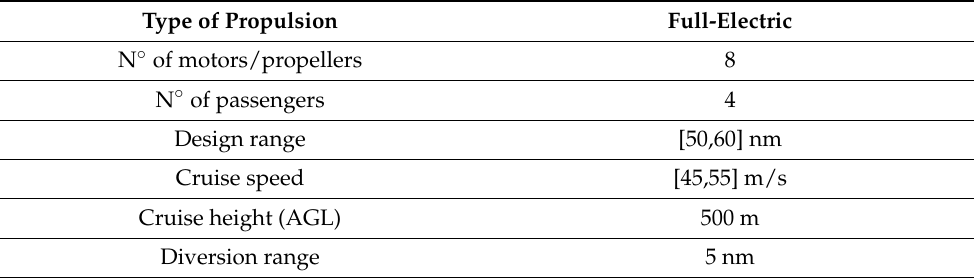
Table 8. Main Top Level Aircraft requirements for the box-wing tilt-wing conceptual